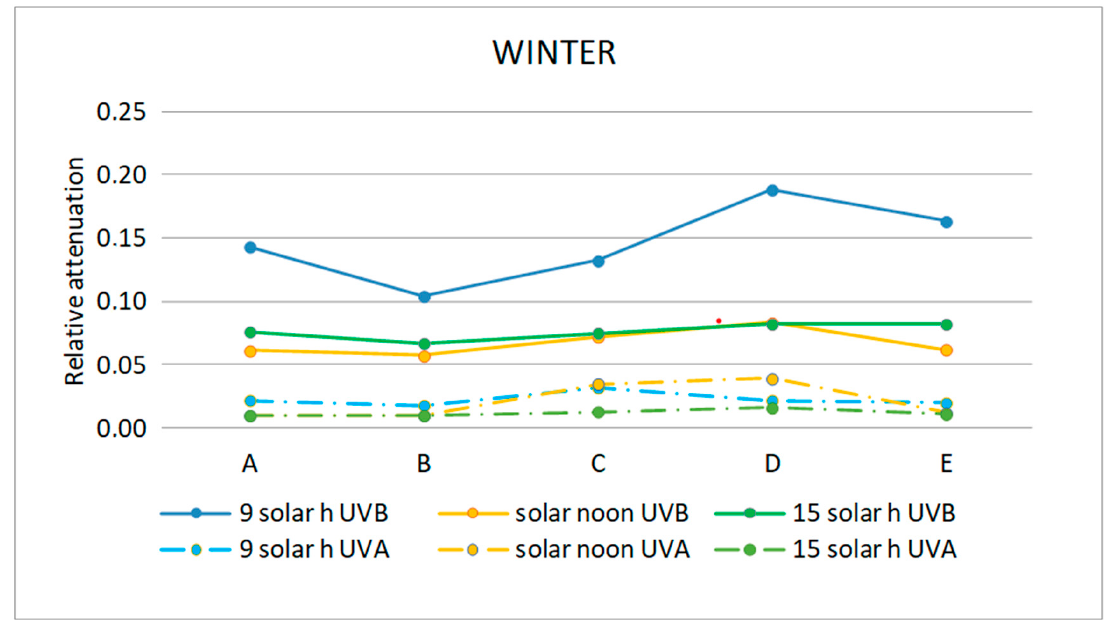
Figure 12. Representation of the mean relative attenuation for the UVB and UVA ranges for the 5 locations studied in winter and at three times of day. Table 4. Values of the mean relative attenuations for the UVB and UVA bands in winter at three times of day.